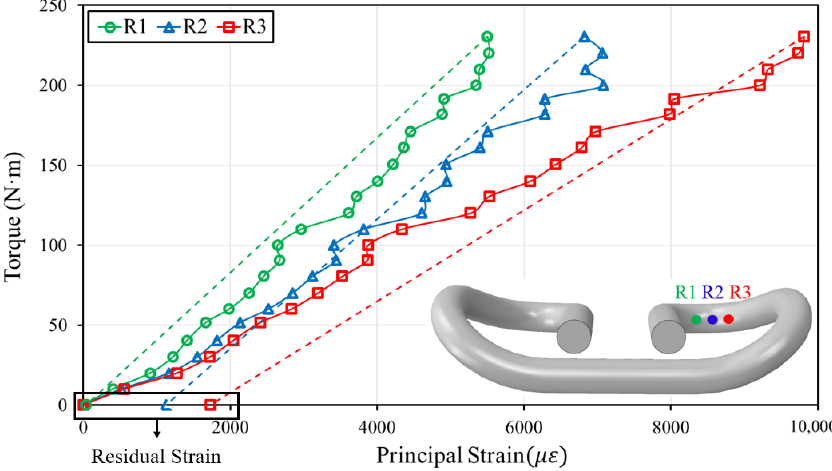
Figure 6. Strain measurements (torque vs. principal strains).